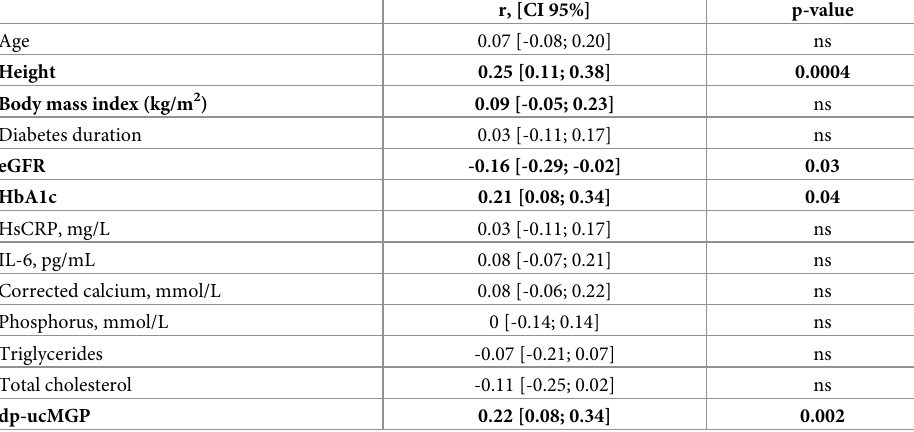
Table 2. Univariate analysis: Correlations between clinical and biological variables and NDS.